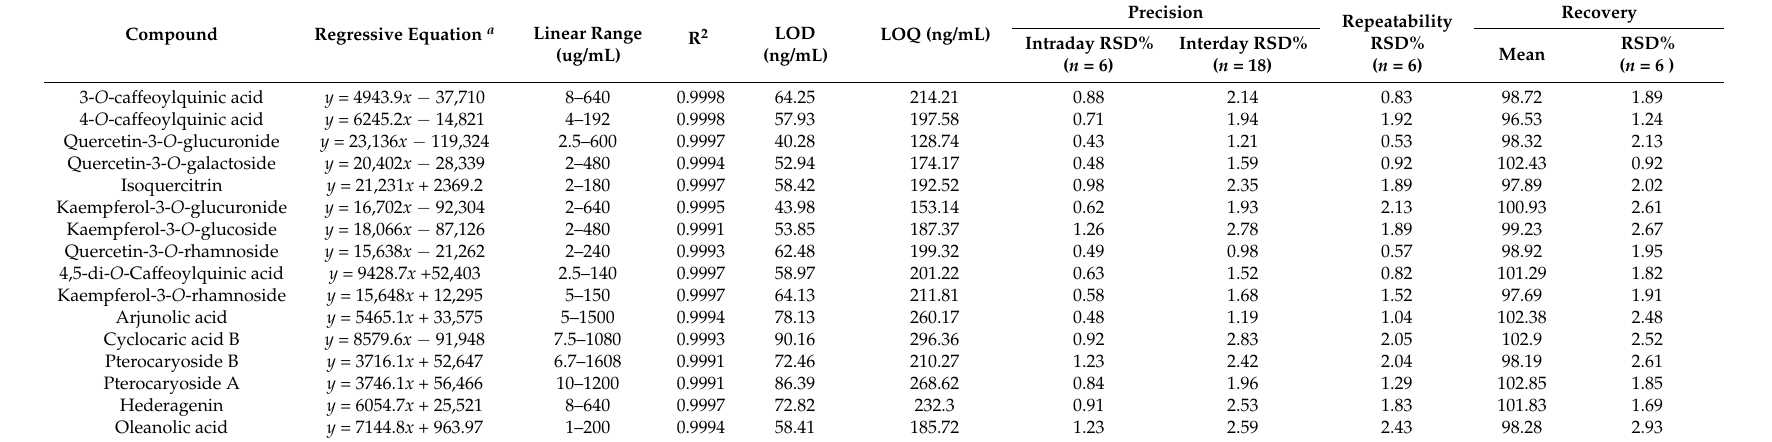
Table 3. Method validation for simultaneous quantification of 16 constituents in C. paliurus